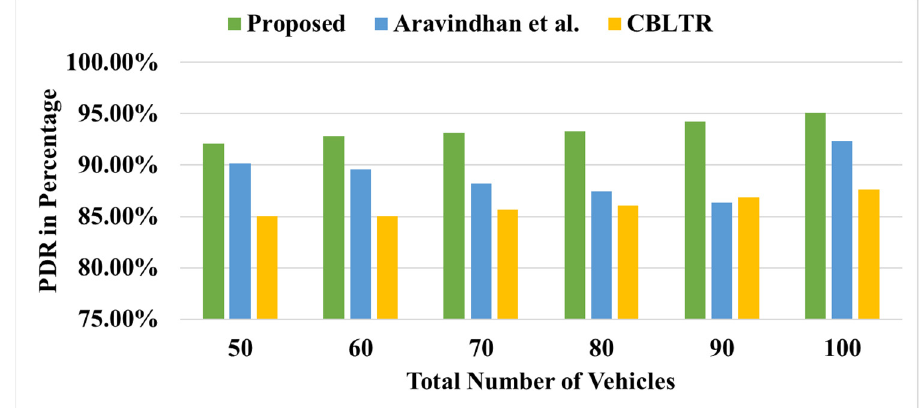
Figure 7. Comparison of results of the proposed system and existing systems (Aravindhan et al.